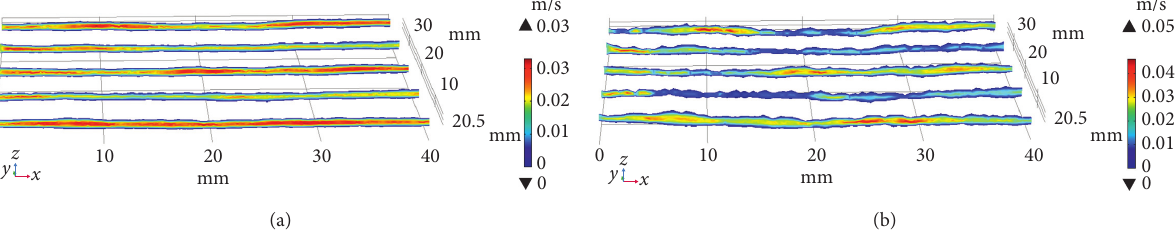
Figure 5: Velocity distribution for D � 2.5, Q � 5.3796 × 10 − 7 · m 3 /s. (a) δ � 0.09mm. (b) δ � 0.21mm.